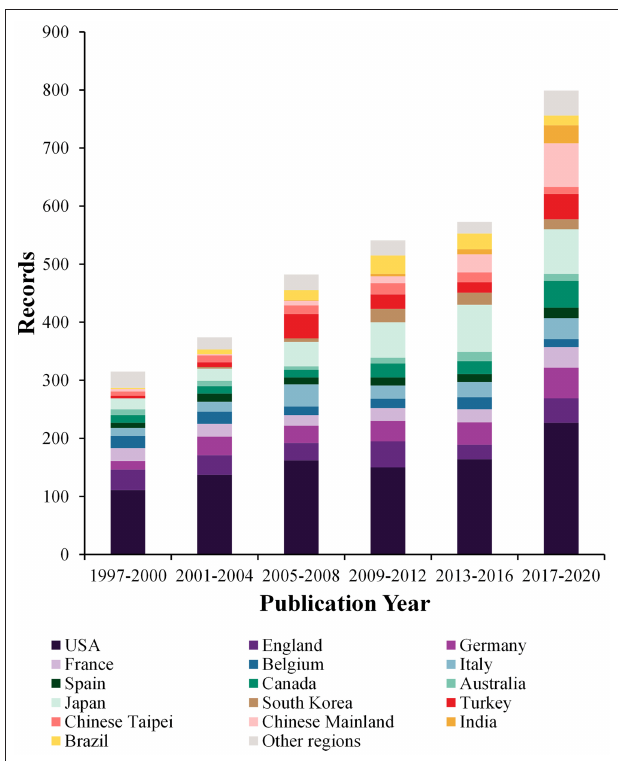
FIGURE 1 | Quantitative growth process of the studies from different countries and regions concerning pediatric liver transplantation (PLT) in 24